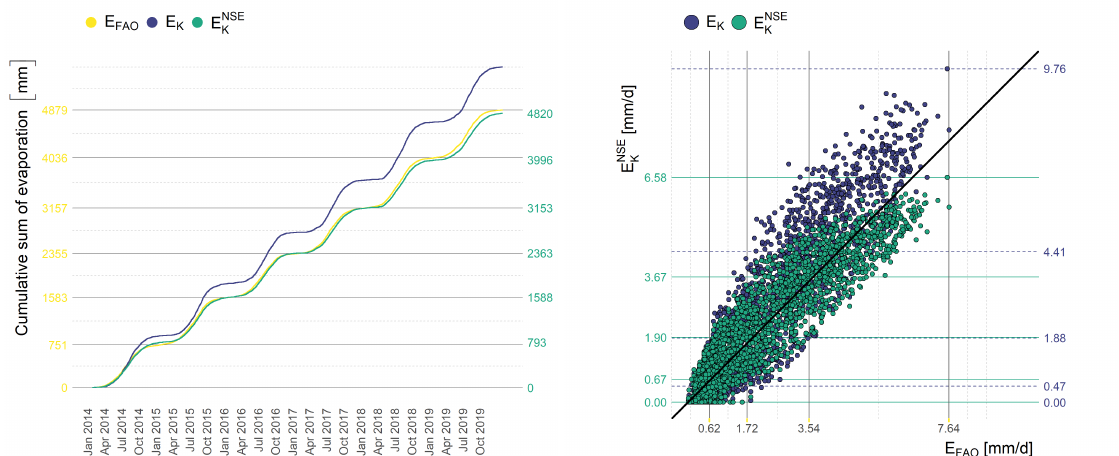
Figure 8. The comparison of the daily evaporation computed by FAO Penman–Monteith equation, Kharrufa equation, and calibrated Kharrufa equation with respect to NSE in the form of cumulative evaporation ( left ) and the scatter plot ( right ).